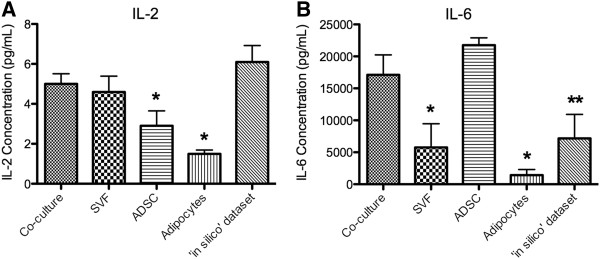
Concentration of cytokines with dual roles measured in conditioned medium of adipose-derived cell populations. The concentrations of the cytokines, IL-2 (A), and IL-6 (B) were measured in the conditioned medium of the stromal vascular fraction (SVF) co-cultured with adipocytes, SVF, adipose-derived stem cells (ADSC), and adipocytes, as well as the ‘in silico’ dataset. The reported values are the average of 5 biological replicate ± SEM. An * denotes a p-value of ≤ 0.05 and an ** denotes a p-value ≤ 0.1 when compared to the co-culture dataset.